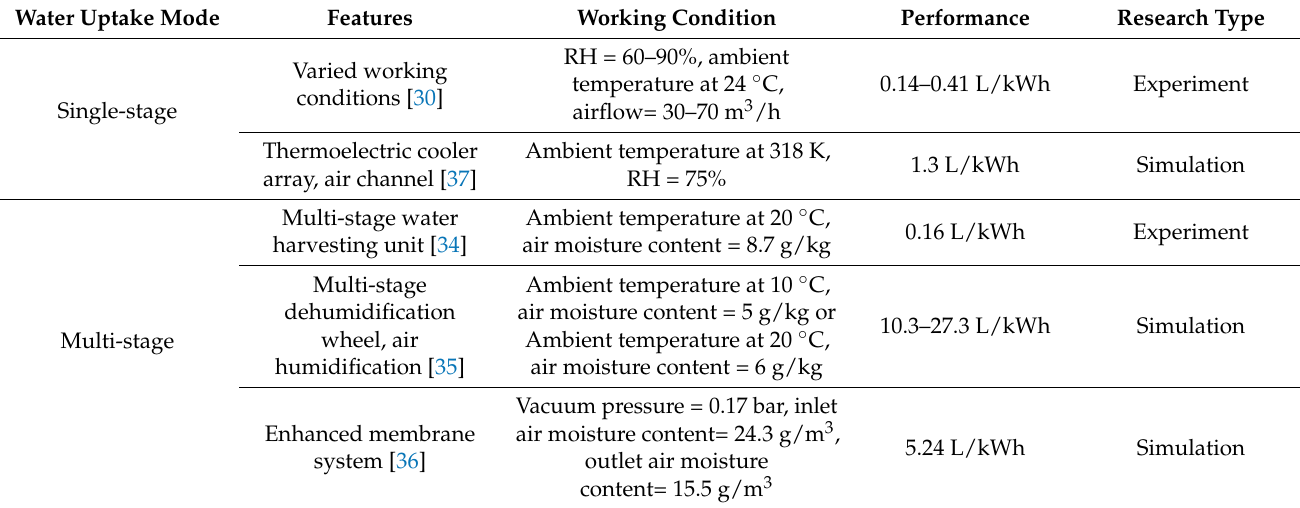
Table 1. Features and parameters of selected atmospheric water harvesting systems based on